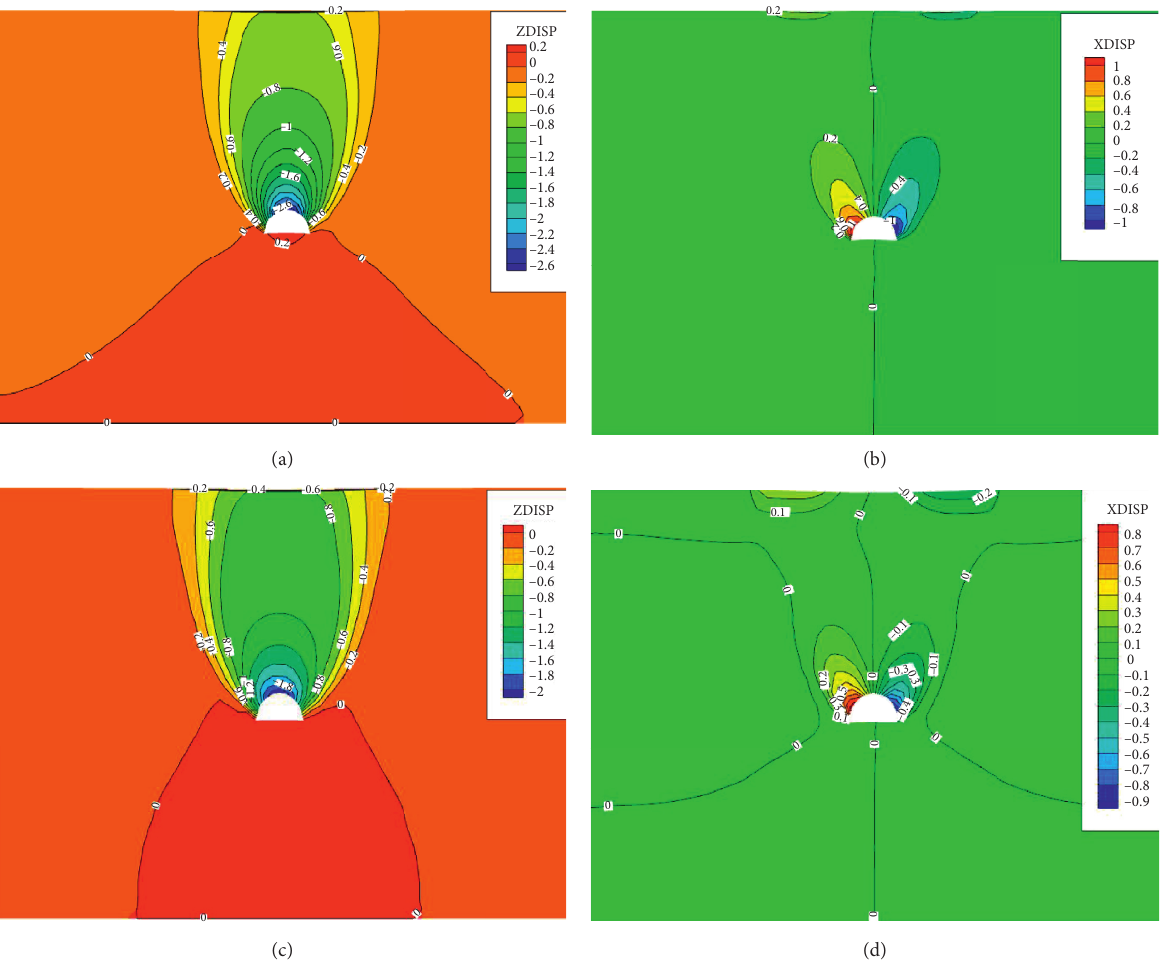
Figure 3: Displacement contour of surrounding rock of tunnel under no support and original support. (a) Contour of Z -displacement under no support. (b) Contour of X -displacement under no support. (c) Contour of Z -displacement under original support. (d) Contour of X -displacement under original